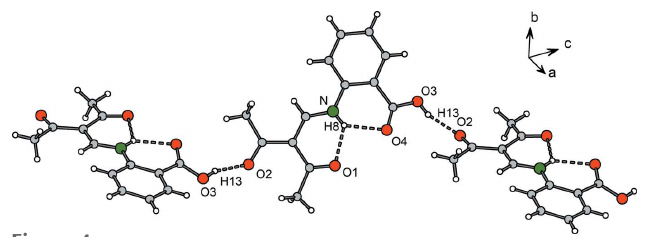
Figure 4 Section of the crystal structure of 1 showing the hydrogen-bonding pattern (dashed lines). Symmetry codes refer to Table 4.